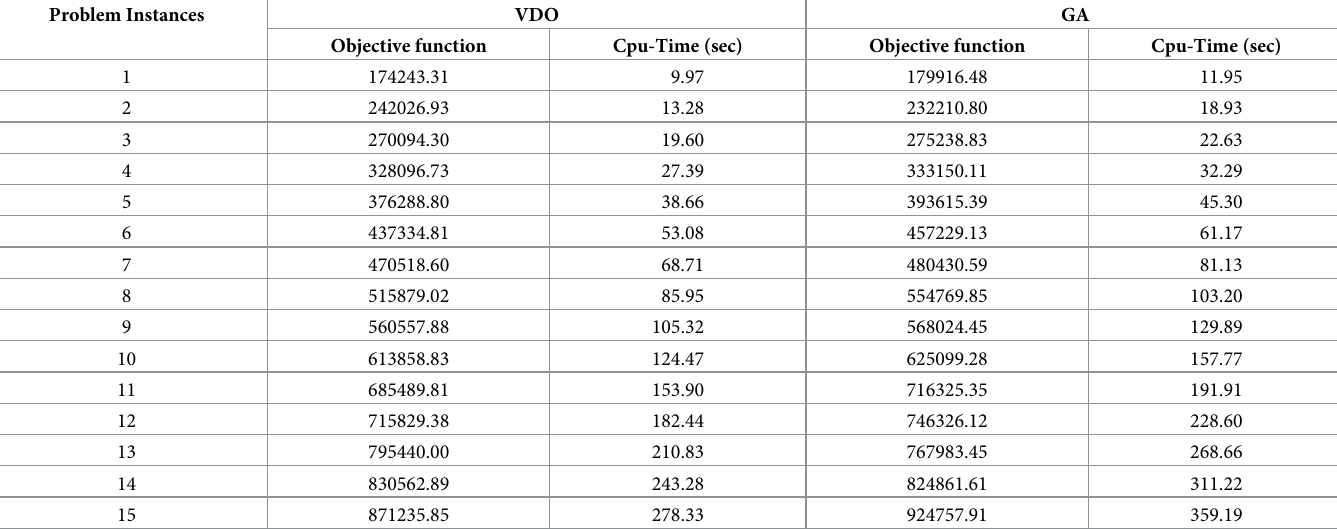
Table 11. The averages of the objective function and computational time in solving the large-sized problems by metaheuristic algorithms. Problem Instances